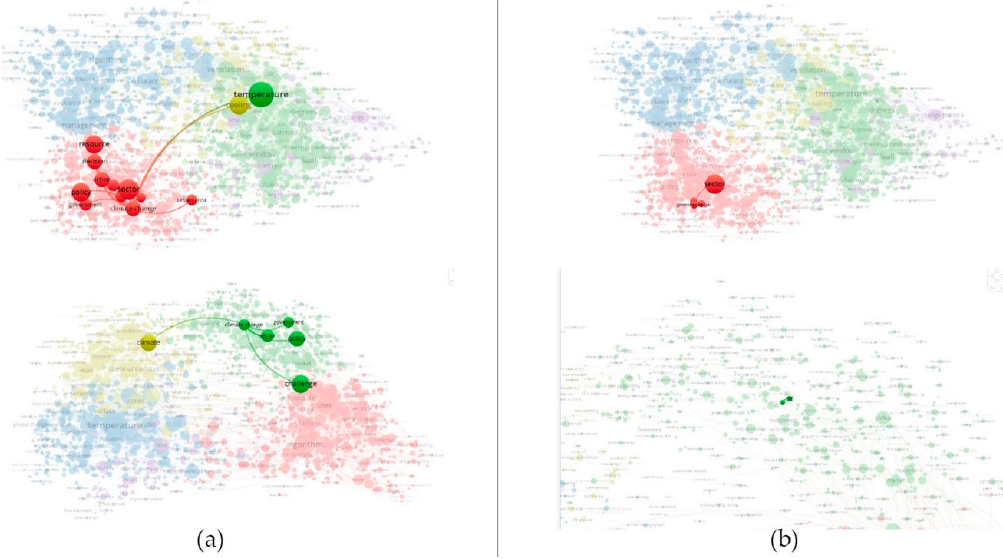
Figure 15. Detail of the co-occurrence of keywords (left: Web of Science, and right: Scopus): ( a ) links of the term “climate change”; ( b ) links of the terms “greenhouse gas”, “greenhouse gases”, and “greenhouse gas emissions”.